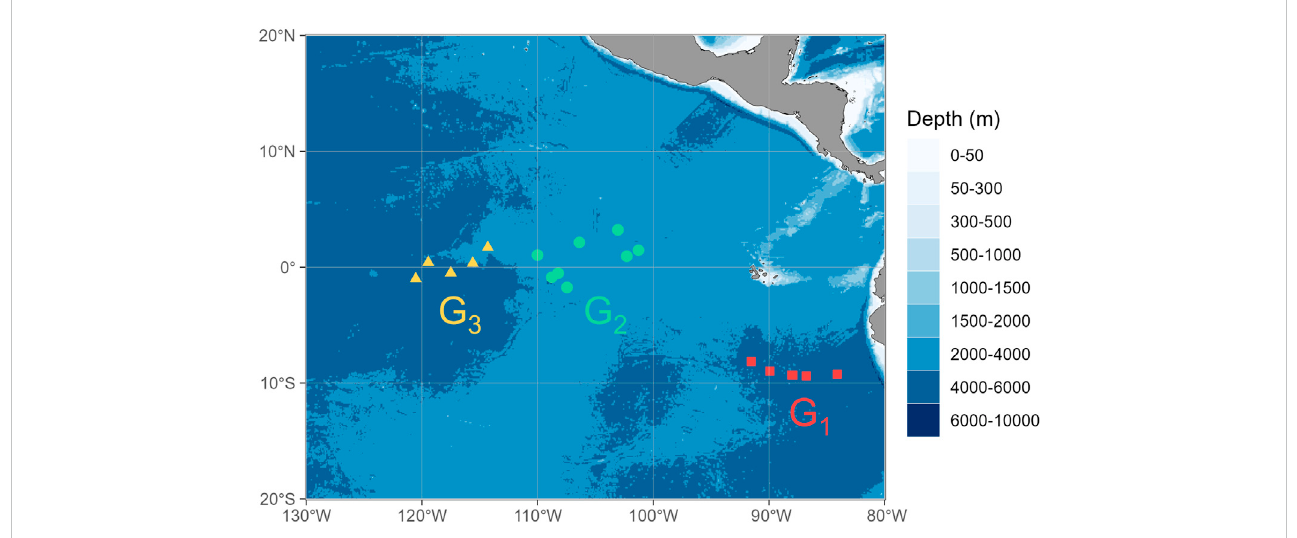
FIGURE 1 Locations where jumbo squid Dosidicus gigas specimens were sampled in the eastern tropical Paci fi c Ocean. Sampling locations are merged into three groups and indicated with squares, circles, and triangles for Group Ⅰ (G 1 ), Group Ⅱ (G 2 ), and Group Ⅲ (G 3 ),